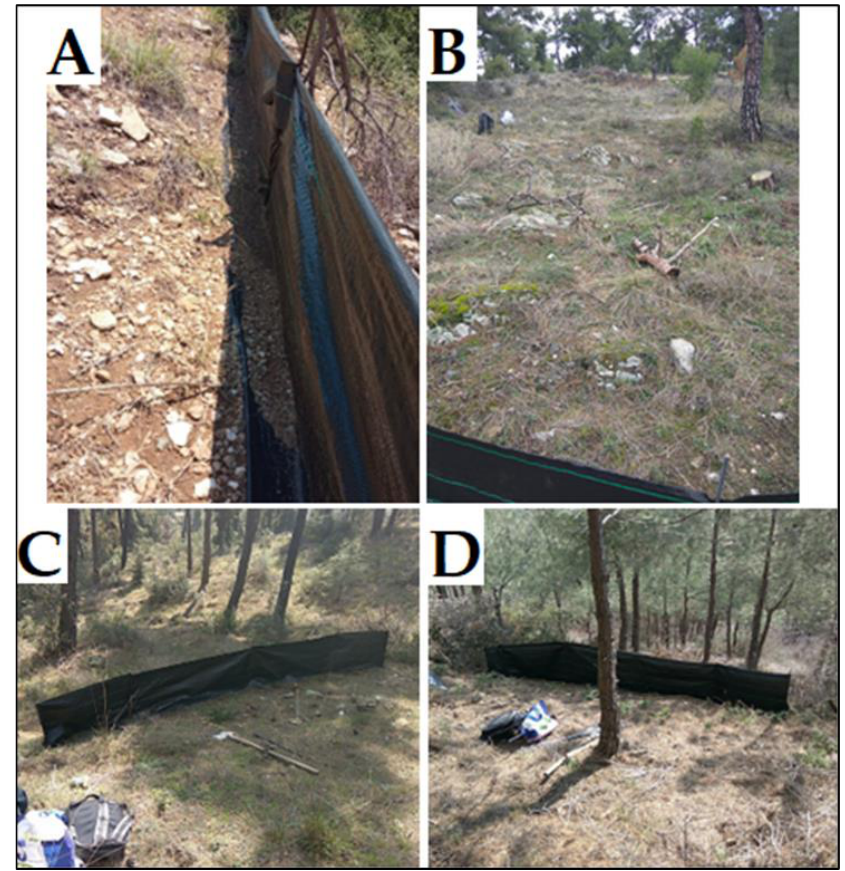
Figure 3. Representative photos from the study area: ( A ) Sediments gathered in silt fence after rain- fall event, ( B ) plot with insect outbreak and logging, ( C ) control plot, ( D ) plot with natural refor- estation.